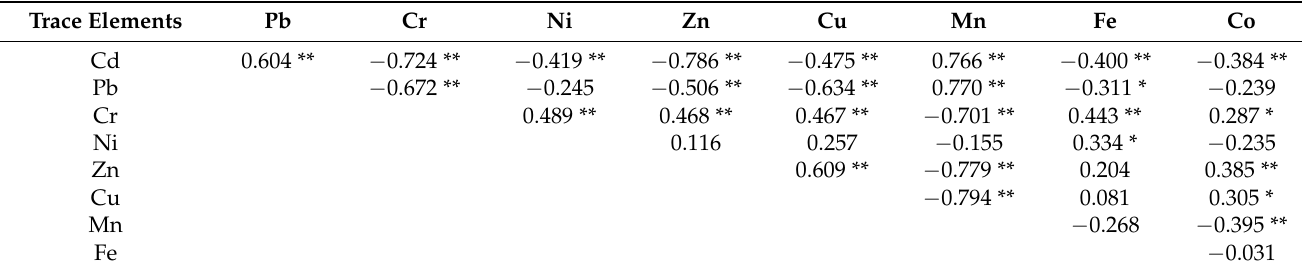
Table 5. Correlation coefficients ( r ) between content of trace elements in aboveground parts of oat— Avena sativa L. Trace Elements